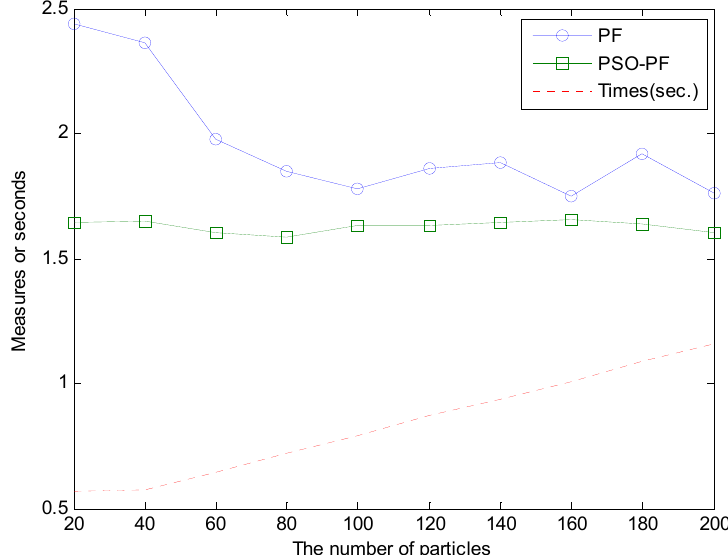
Figure 6. Comparison between particle filter and PSO-PF by using different particle numbers and minimum distances, and relationship diagram of particle filter between different particle numbers and